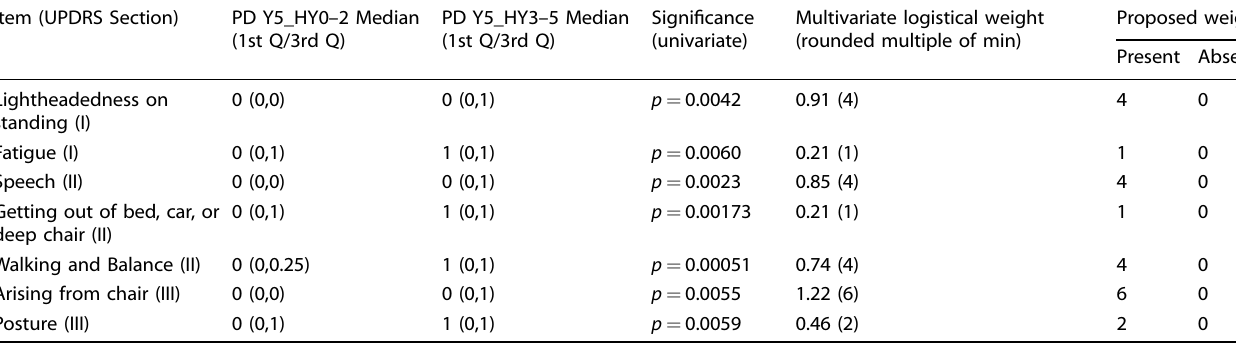
Table 2. Factors associated with progression to HY Stage 3 or worse within the fi rst 5 years of disease. Item (UPDRS